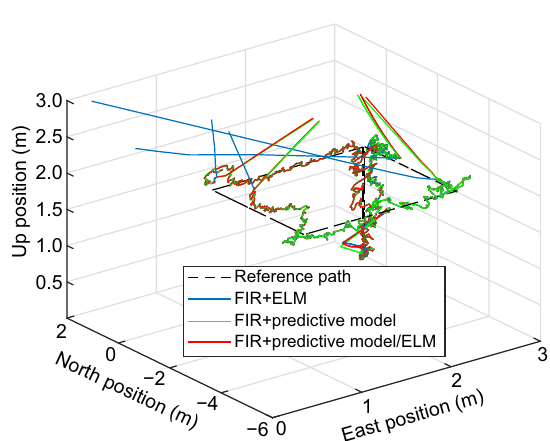
Fig. 6 The reference paths and the paths measured by the FIR FIR predictive mode, and the FIR +